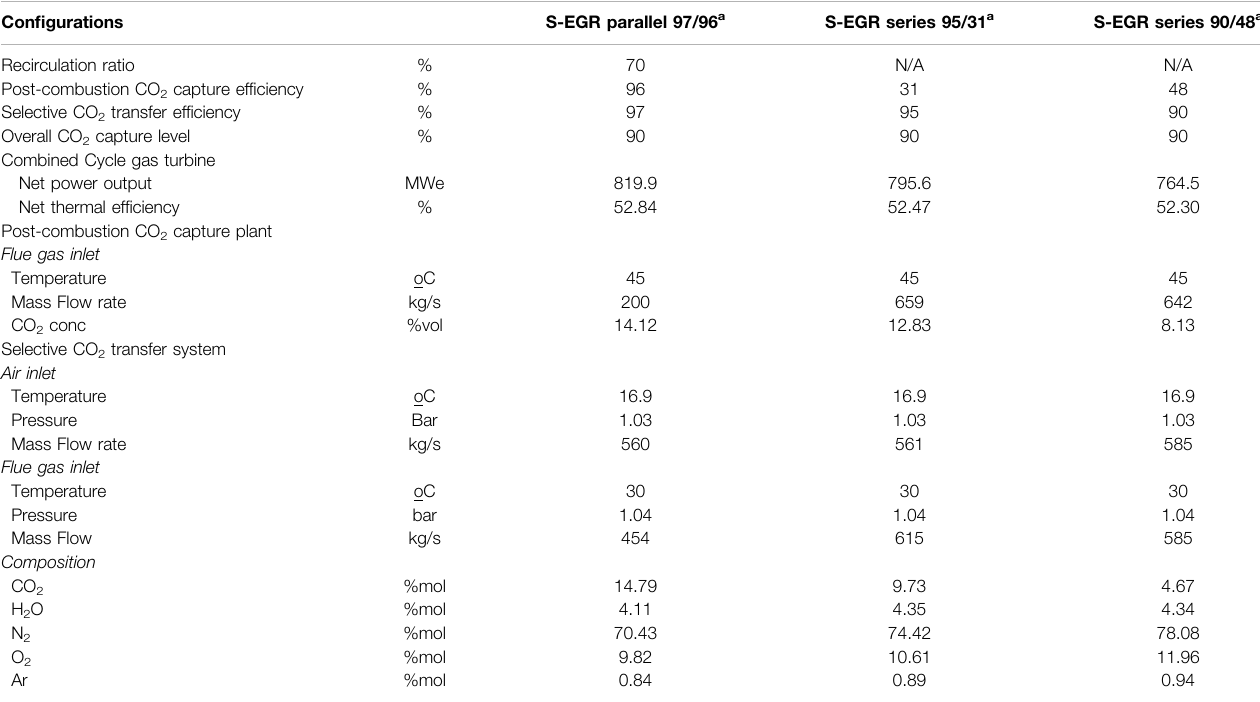
TABLE 2 | Operation conditions and fl ue gas/air inlet streams variables at the selective CO 2 transfer system Con fi